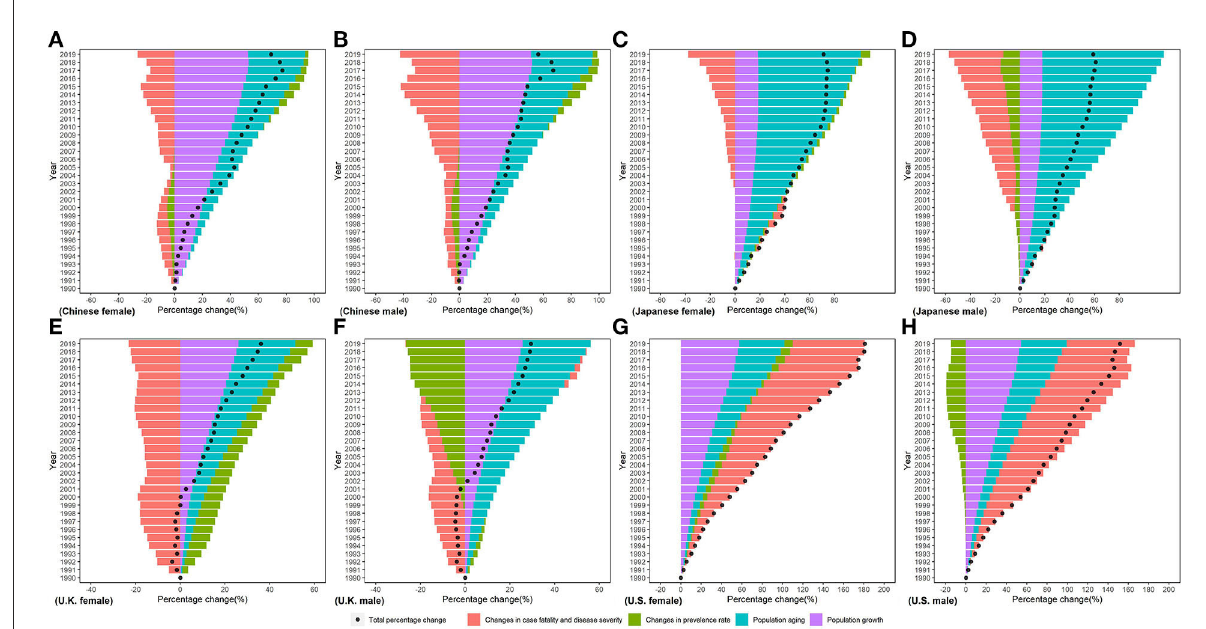
FIGURE8 Percentage change in CKD disability-adjusted life years by sex in (A) Chinese female, (B) Chinese male, (C) Japanese female, (D) Japanese male, (E) U.K. female, (F) U.K. male, (G) U.S. female, and (H) U.S. male in 1990—2019 due to population growth, changes in population age structures, changes in the prevalence rate, changes in case fatality, and disease